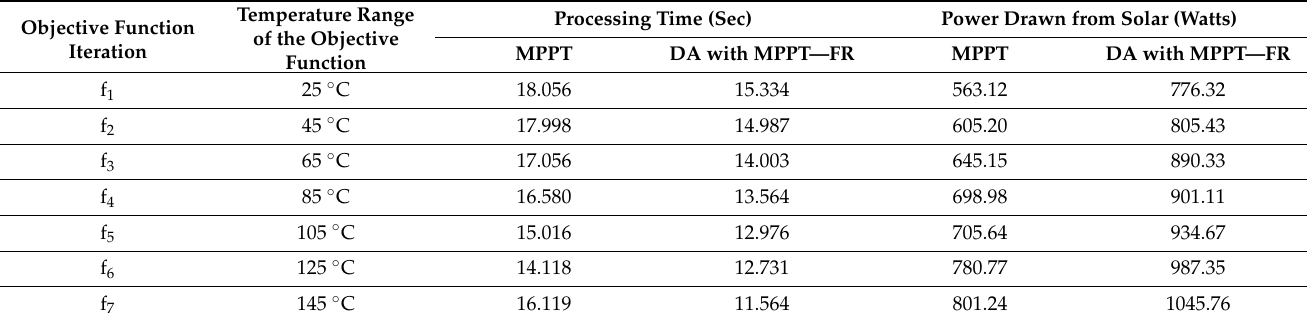
Table 1. Processing time of MPPT and DA—MPPT.